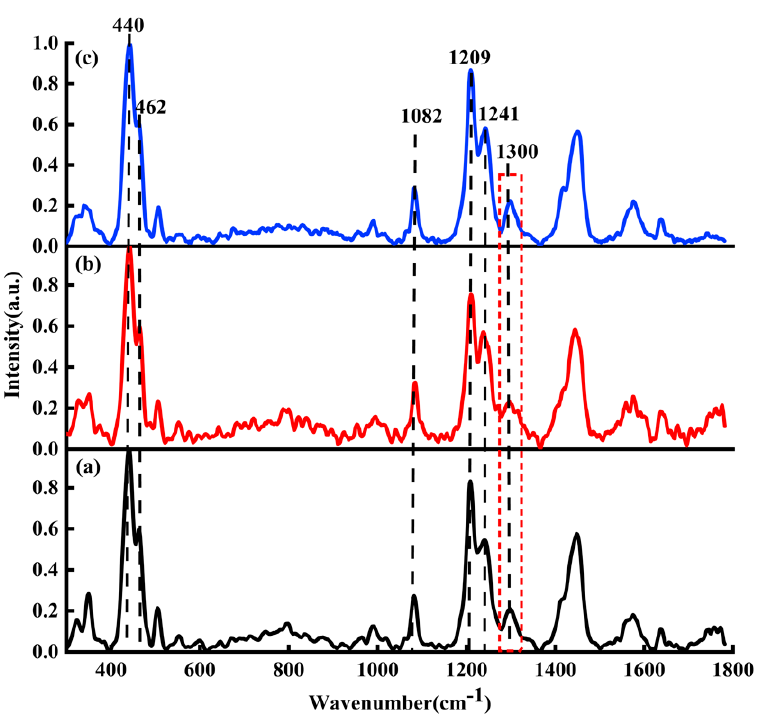
Figure 5. Raman spectra of ( a ) DOX (black line), ( b ) DAU (red line), and ( c ) EPI (blue line). In Figure 6, the black curve represents the average Raman spectrum of ctDNA solu- tion; the red curve represents the average Raman spectrum of DOX-DNA complex ob- tained by DOX interaction with DNA for 24 h; the blue curve represents the average Ra- man spectrum of DAU-DNA complex obtained by DAU interaction with DNA for 24 h; the green curve represents the average Raman spectrum of EPI-DNA complex obtained by EPI interaction with DNA for 24 h. Figure 6. Raman spectra of ( a ) DNA (black line), ( b ) DOX-DNA complex (red line), ( c ) DAU-DNA complex (blue line), and ( d ) EPI-DNA complex (green line).